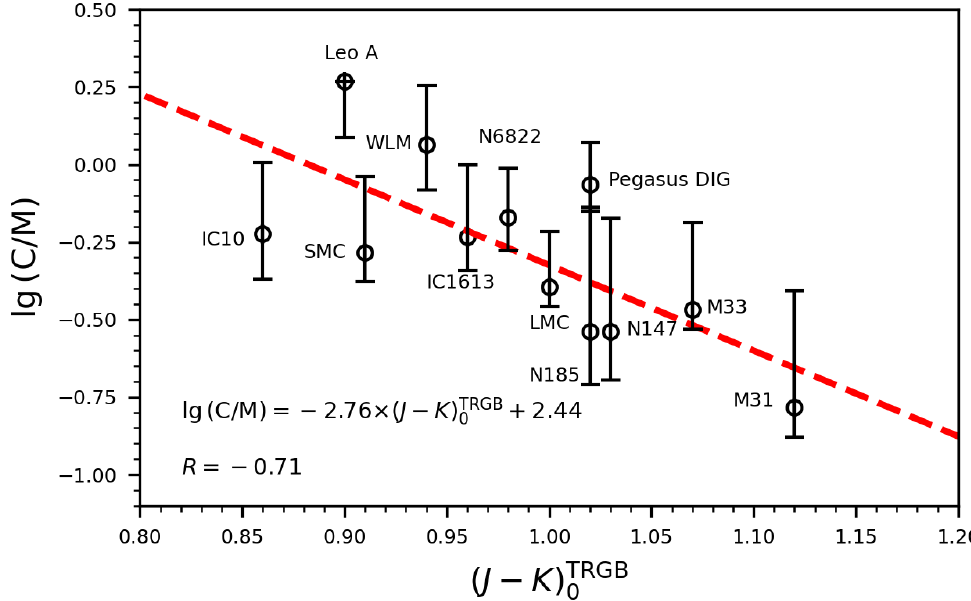
Figure 3. Dependence of lg ( C/M ) with ( J − K ) TRGB represents the linear fitting whose result with the Pearson’s correlation coefficient is displayed in the lower-left